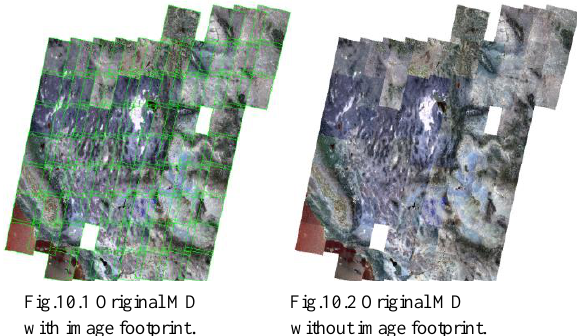
Fig.10.1 Original MD Fig.10.2 Original MD with image footprint . without image footprint.